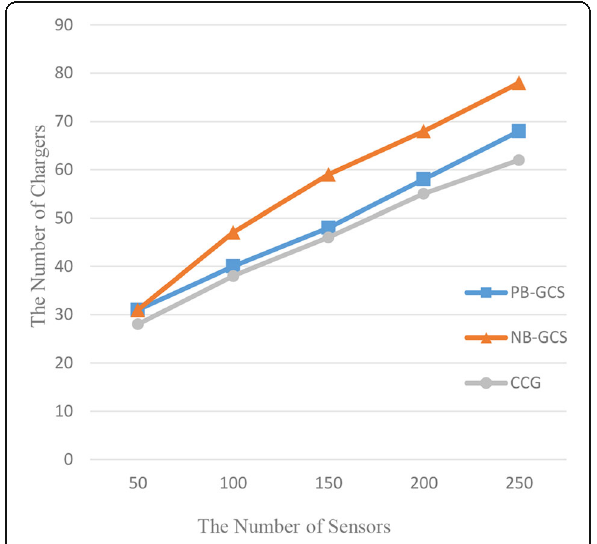
Fig. 7 Comparison between CCG, APB-GCS, NB-GCS, and PB-GCS algorithms when 80% nodes are covered